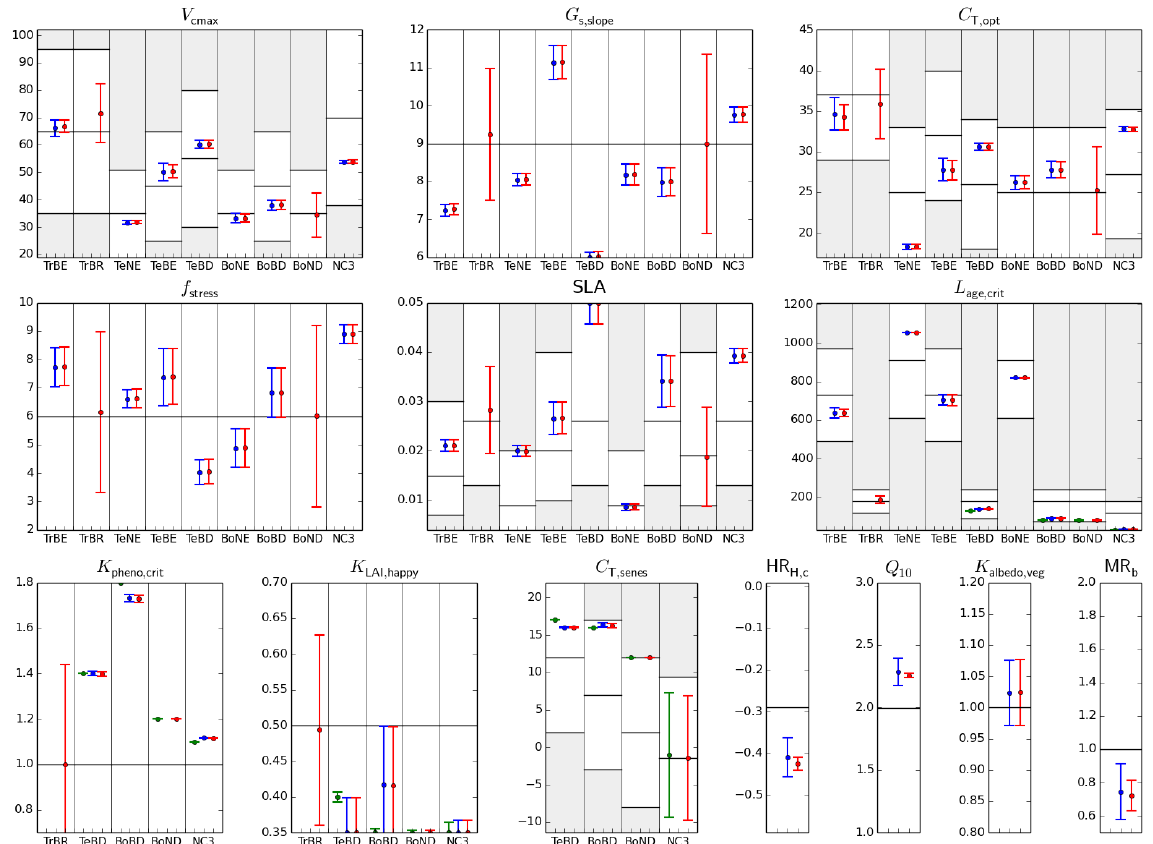
Figure 9. Prior and posterior parameter values and uncertainties for a set of optimized parameters (nine PFT dependent and four non-PFT dependent). The prior value corresponds to the horizontal black line and the physical allowed range of variation to the “ y ” range (i.e., the white zone). For PFT-dependent parameters, there are nine sub-plots corresponding to PFTs that were optimized (except for K pheno , crit with only five PFTs). For each parameter, there are three estimated values for the three successive steps: step 1: assimilation of MODIS-NDVI data (green symbol); step 2: adding FLUXNET data (blue symbol); step 3: adding atmospheric CO 2 data (red symbol). The parameter values are depicted with the symbols and the estimated uncertainties with the vertical line ( ± σ